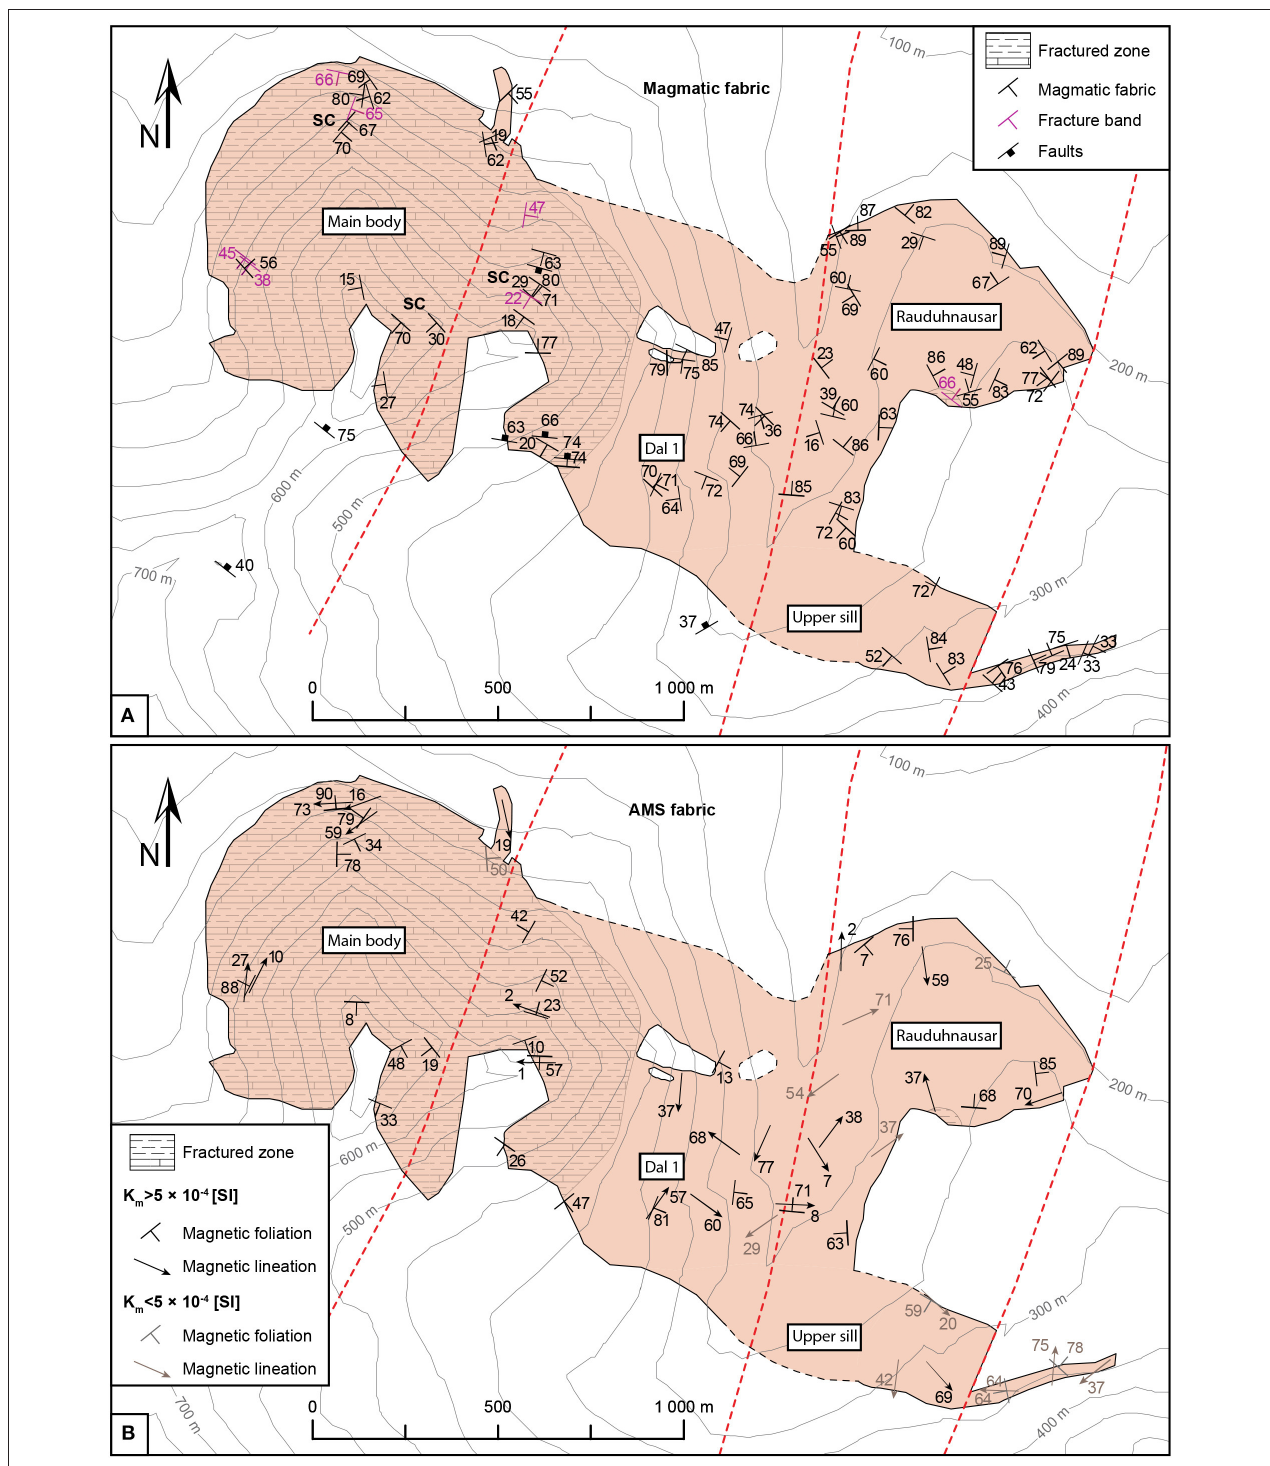
FIGURE 7 | (A) Magmatic flow indicator measurements (mineral alignments, flow bands, platy parting) and fracture bands and larger-scale faults in the Sandfell laccolith. Areas with observed S-C fabric are denoted with the letters “SC” in bold on the map. (B) AMS fabric plotted on map of the Sandfell laccolith. The map includes data from samples with weak magnetic fabric ( K m < 5 10 − 4 [SI]). The fracture-banded areas of the laccolith are specified on the map as fractured zone. × See Supplementary Video S1 for a 3D interpretation of magma flow.